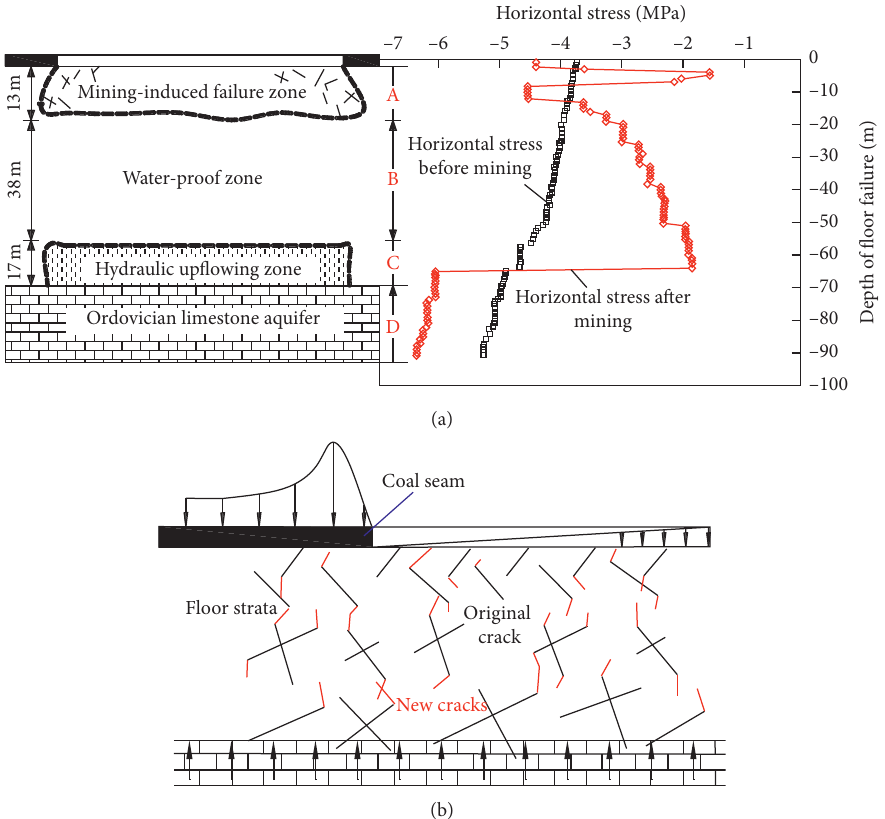
Figure 8: Failure characteristics and the horizontal stress distribution of floor after mining: (a) characteristic zoning of floor failure and horizontal stress after mining; (b) crack propagation in the rock